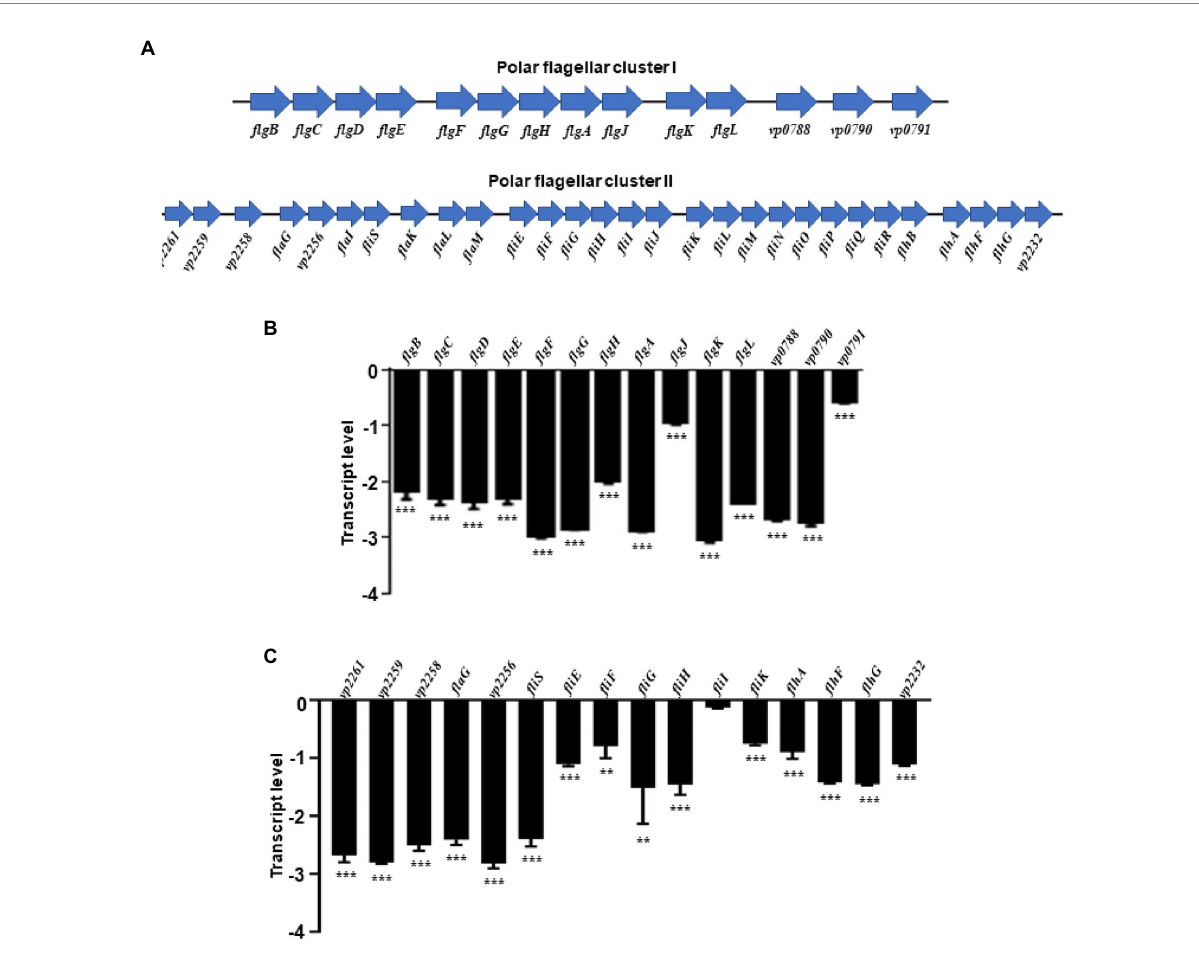
FIGURE 2 The RpoN positively regulates the expression of flagellar clusters. (A) Genetic map of polar flagellar cluster I and cluster II genes in V. parahaemolyticus . (B,C) qRT-PCR analysis of the transcription levels of polar flagellar cluster I genes (B) and polar flagellar cluster II genes (C) . The data are presented as the mean ± SD ( n = 3). ** p < 0.01, *** p < 0.001, Student’s t test analyzes Δ rpoN compared to